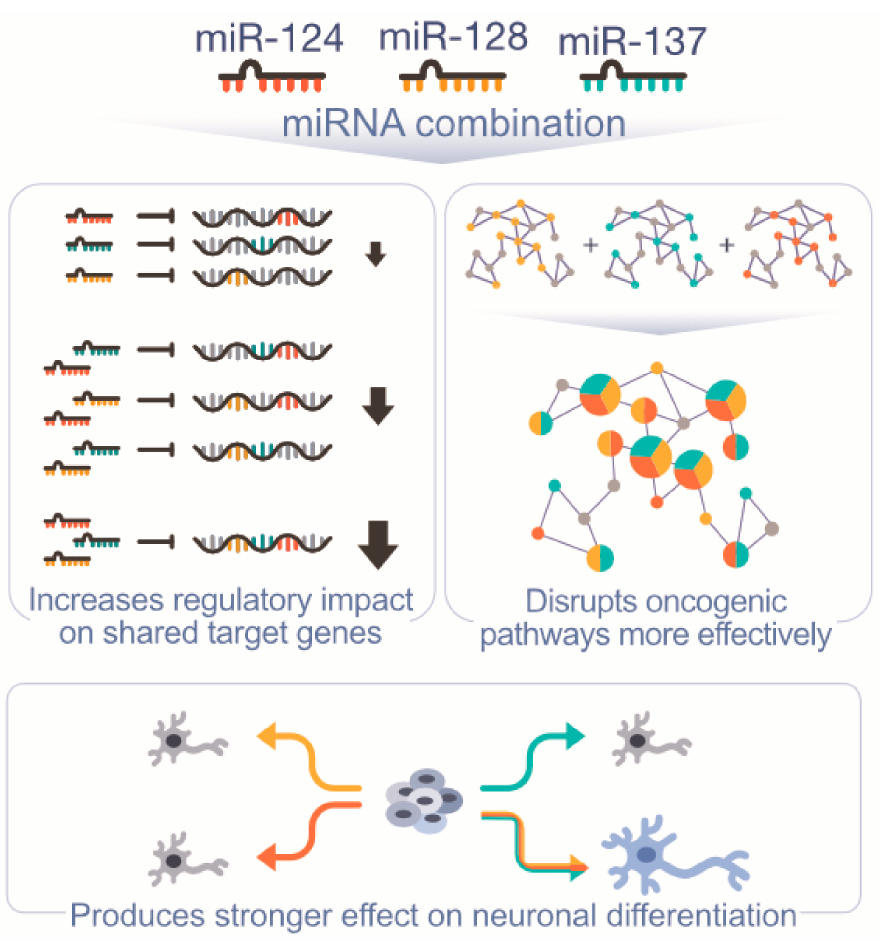
Figure 1. miR-124, miR-128, and miR-137 synergism. Model for synergistic interactions between miR-124, miR-128, and miR-137. Combined action of the three miRNAs on shared and associated targets produces a stronger regulatory effect. This includes a stronger repression of shared targets, increased effect on neuronal differentiation, and broader and stronger impact on oncogenic